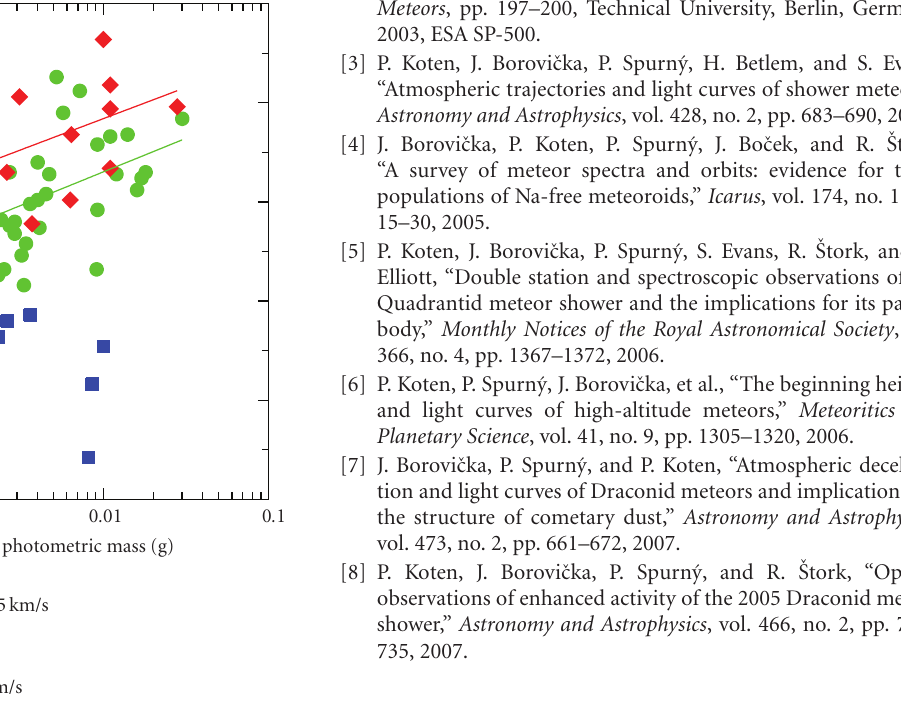
Figure 7: Beginning heights as function of the photometric mass of the meteoroids compared with the sporadic meteor of similar